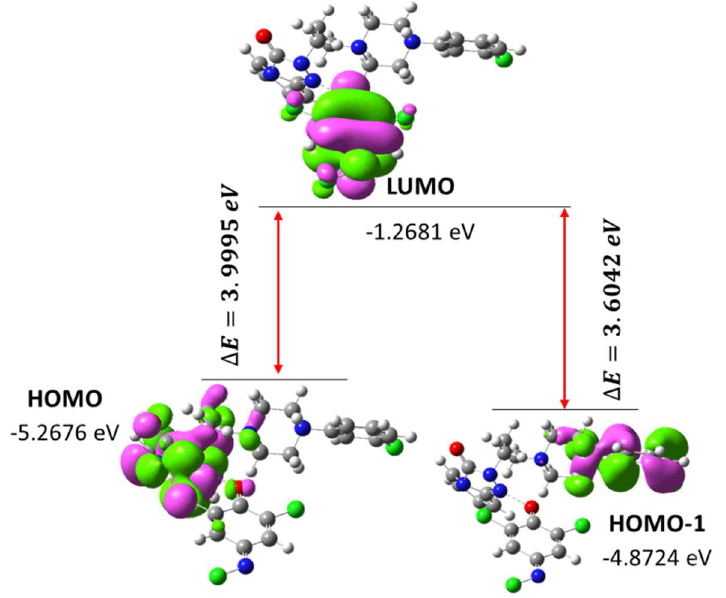
Figure 18. HOMO and LUMO of [(TZD)(DCQ)] complex and their energy gap. Table 3. The theoretical molecular characteristics of the [(TZD)(DCQ)] complex. Parameters RB3LYP/6-311G++ Minimum SCF energy (a.u.)